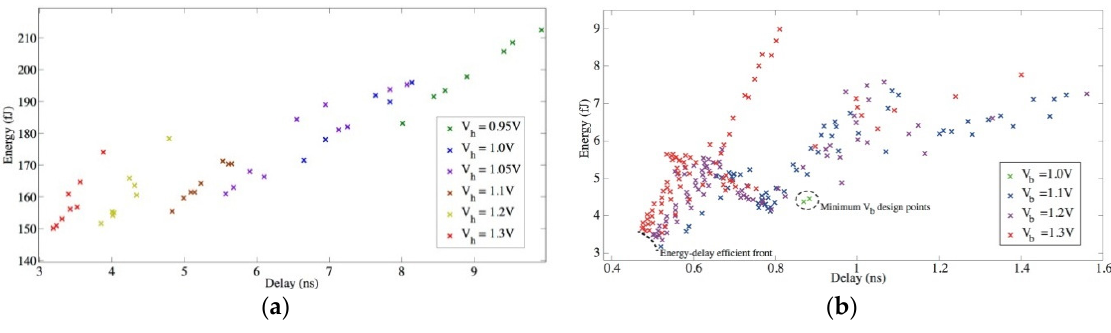
Figure 5. Design space exploration with energy versus switching delay ( a ) STT ‐ MTJ, ( b ) VCMA ‐ MTJ .